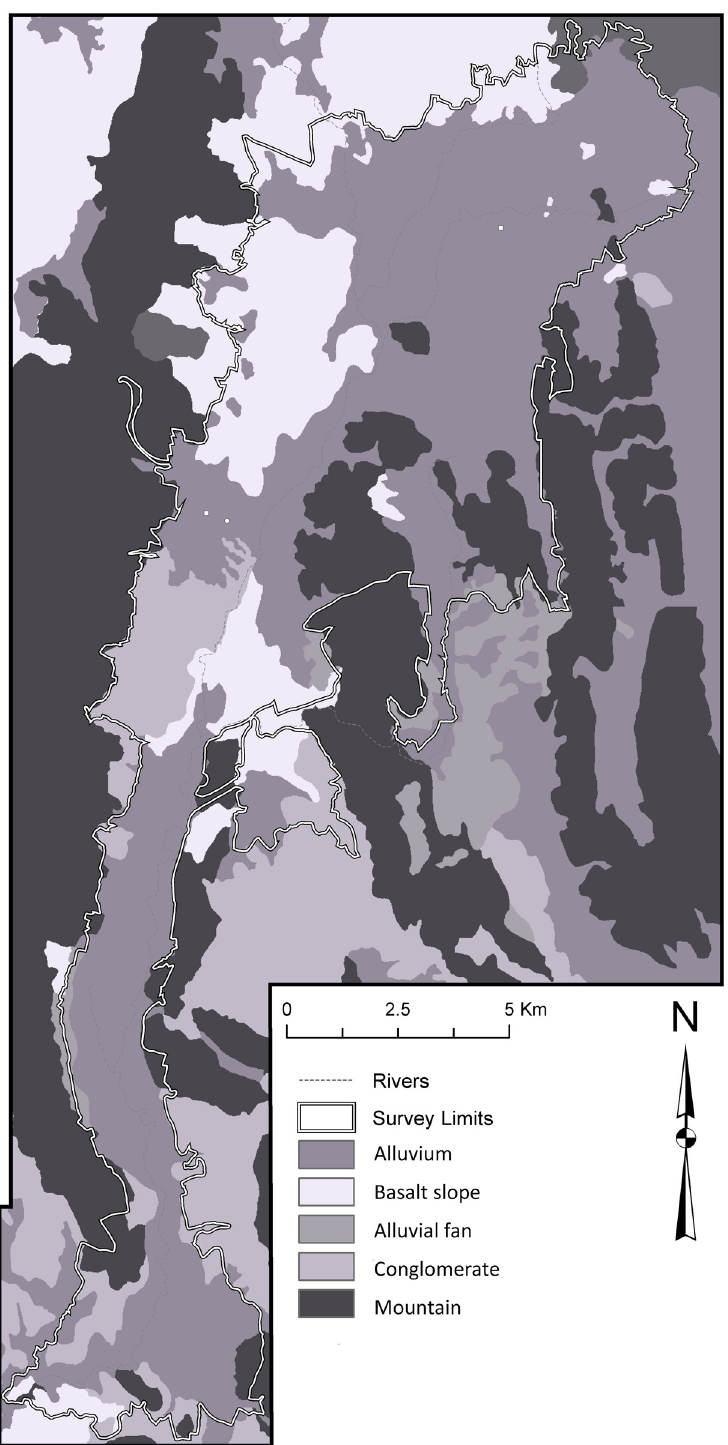
Figure 3: Extent of our survey in relation to environmental zones in the Yautepec